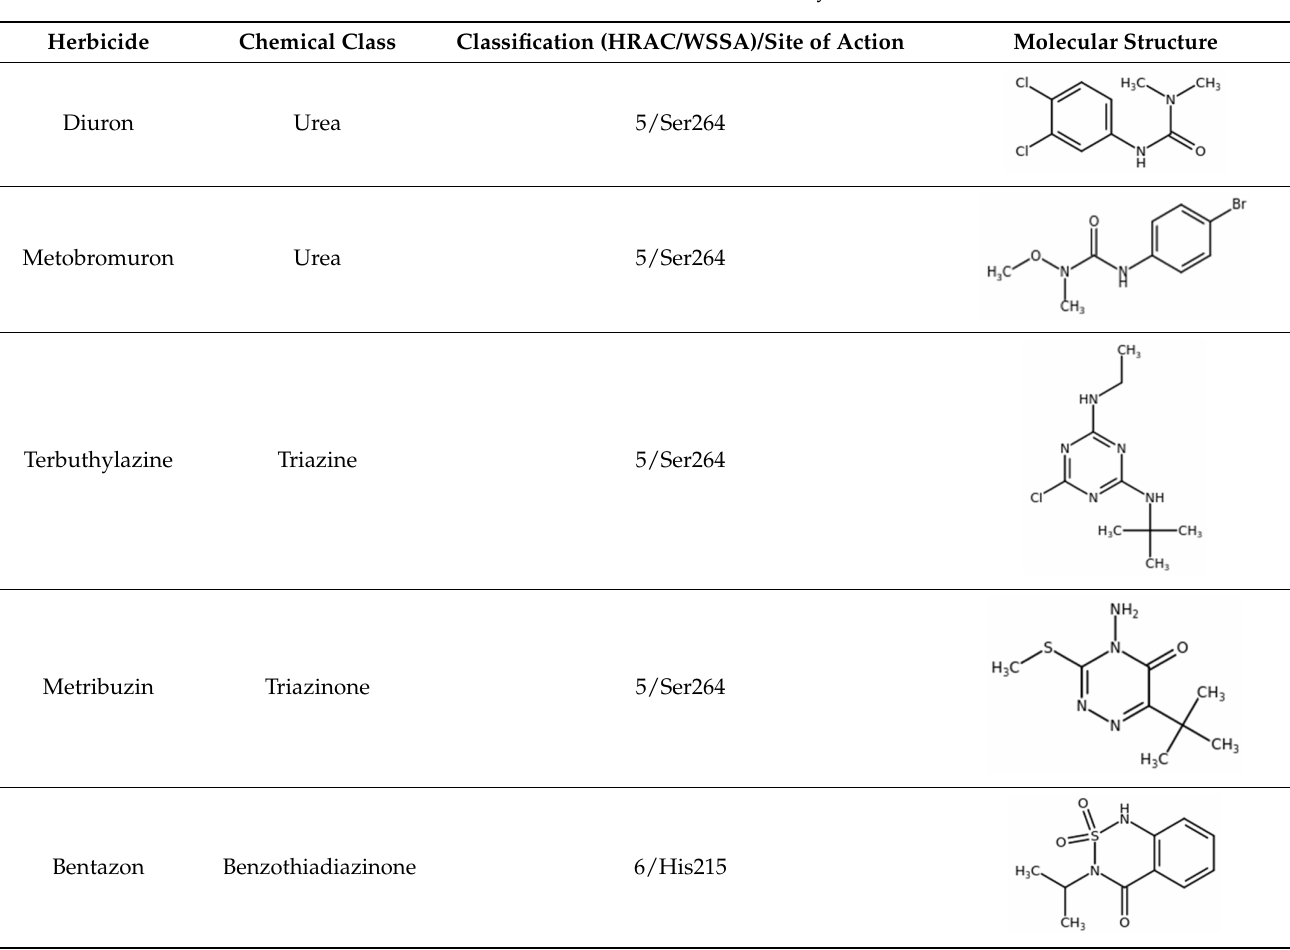
Table 1. Herbicides used in this